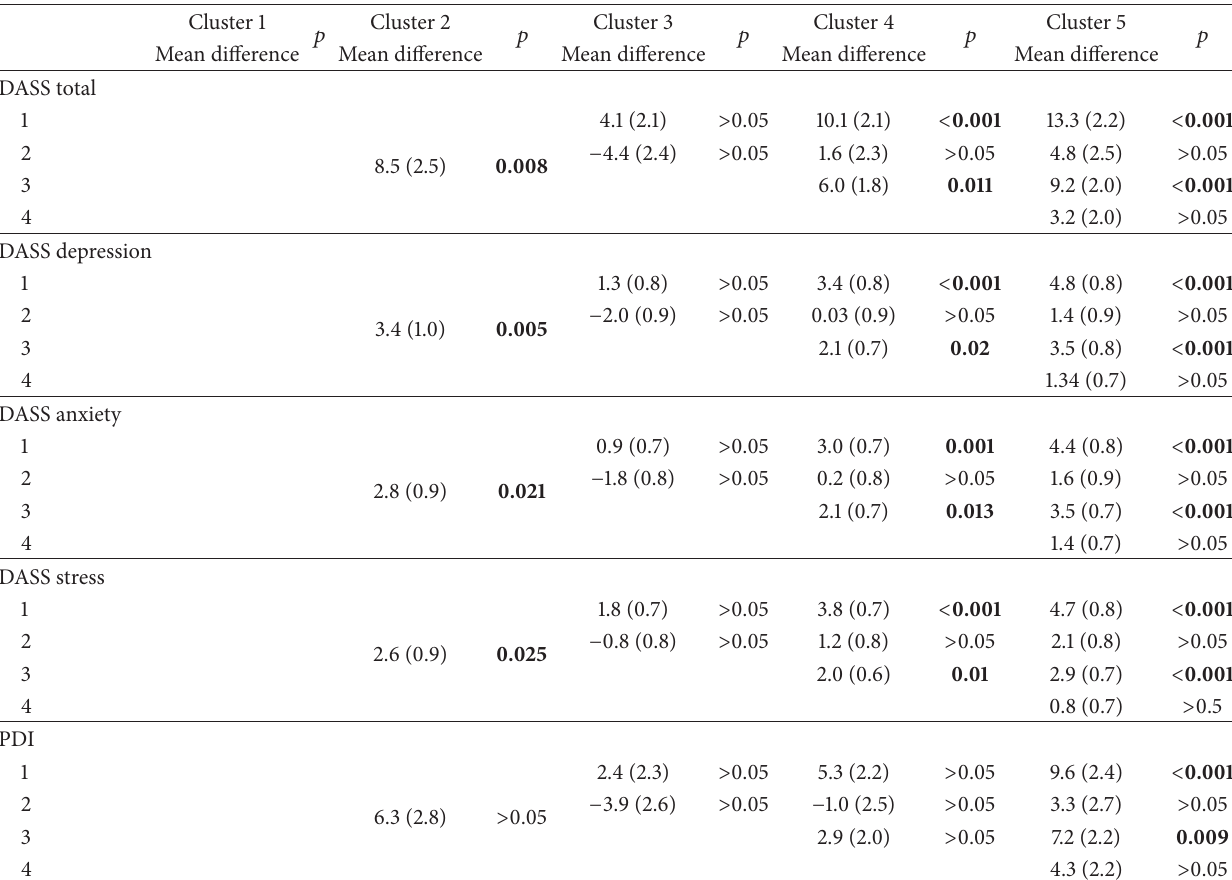
Table 4: Post hoc analysis in mood and disability among clusters